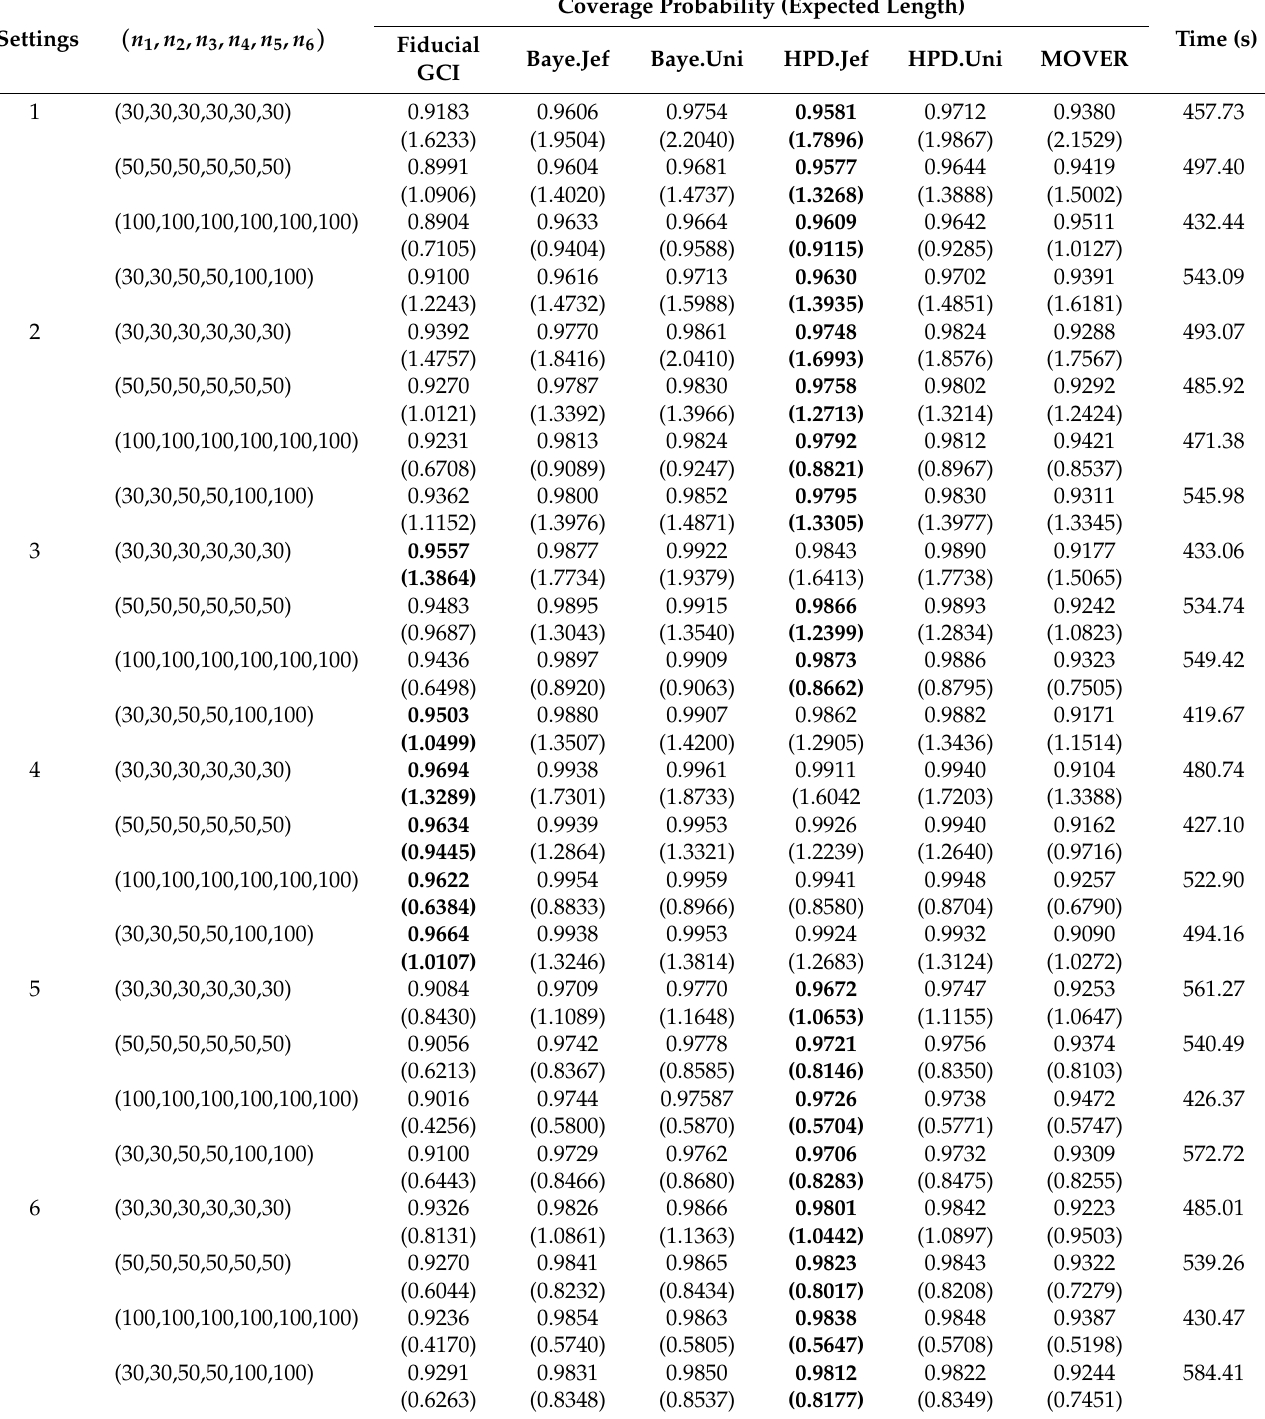
Table 4. Coverage probabilities and expected lengths for the 95% simultaneous CIs with λ il ( k = 6 )